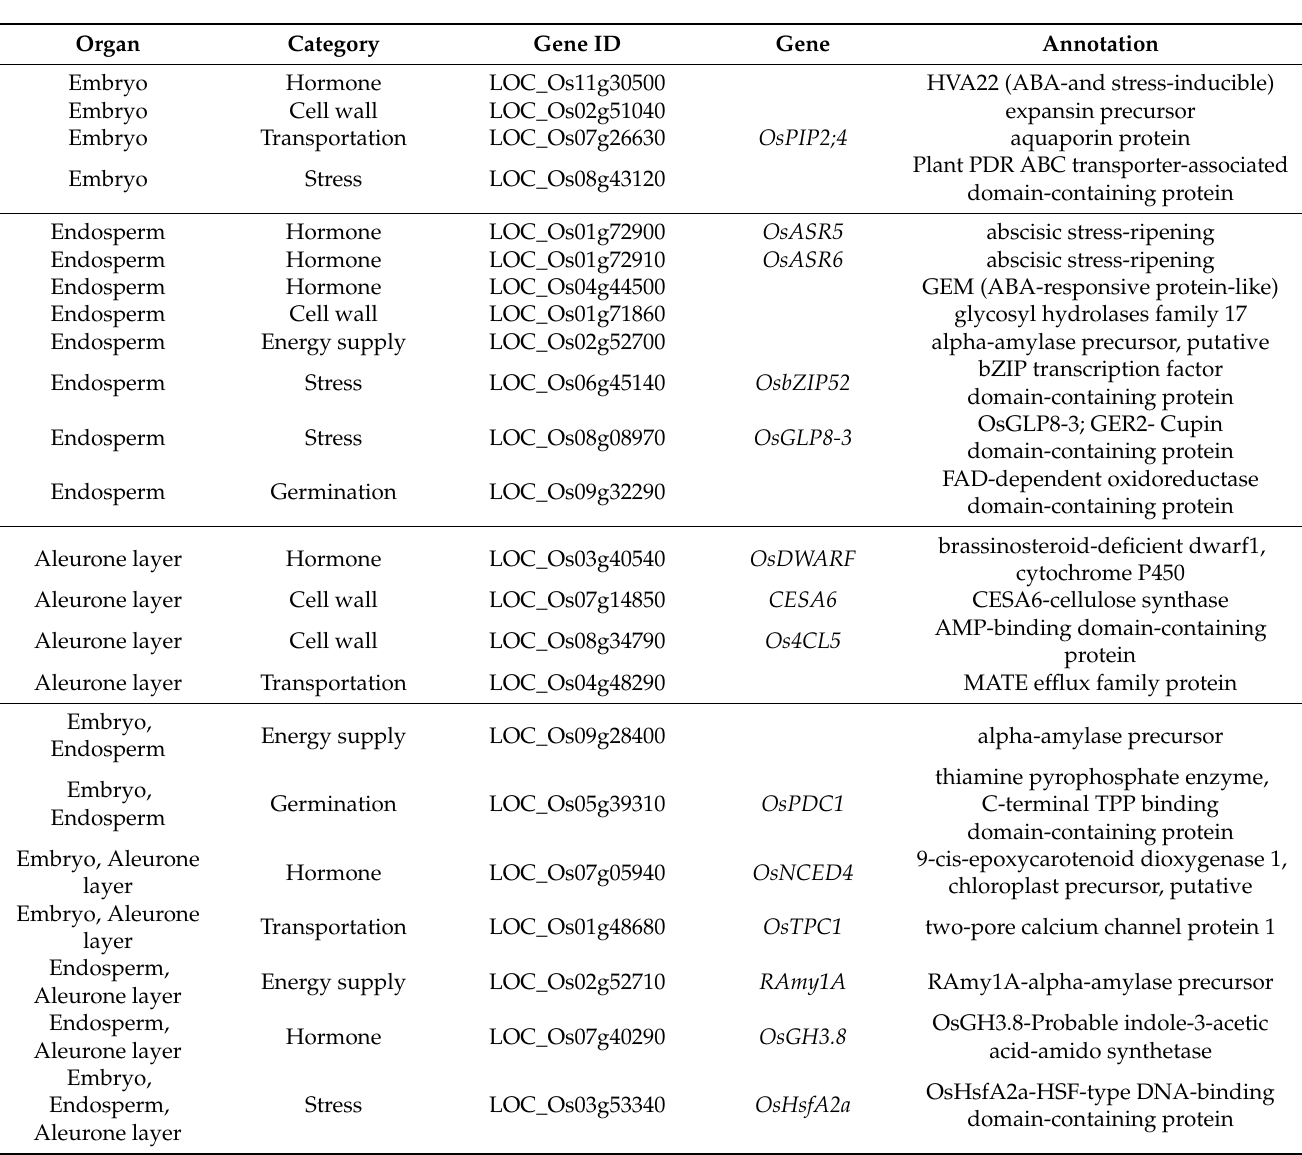
Table 3. Selected down-regulated DEGs in seven